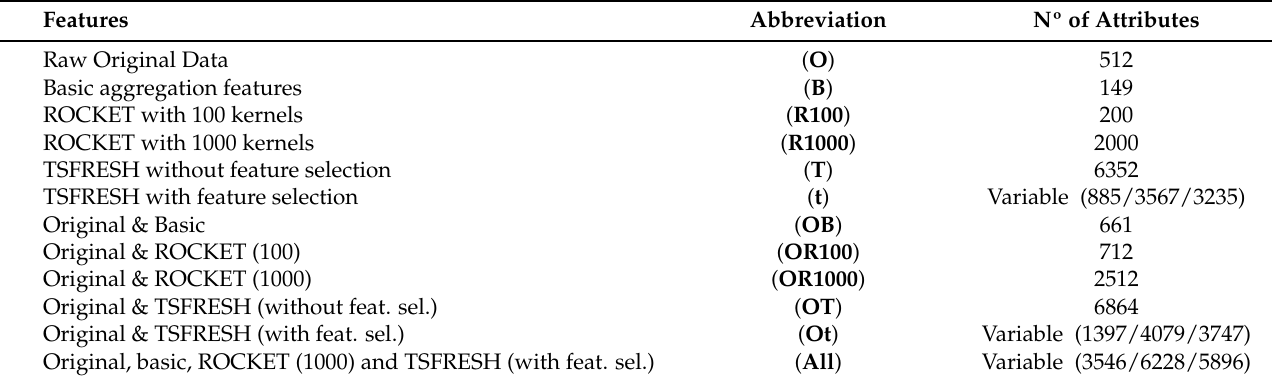
Table 2. Combination of features used, including their total number. In the case of variable-size feature extraction methods, the minimum, maximum, and average values, respectively, are also given (in parenthesis).